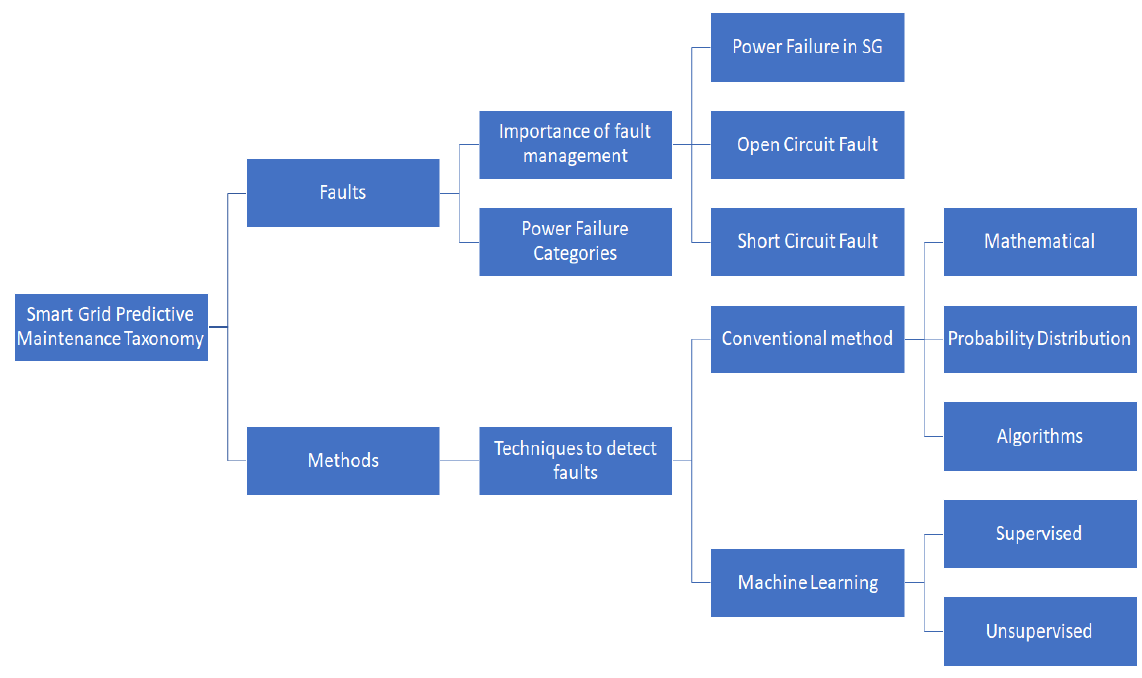
Figure 1. Smart grid predictive maintenance taxonomy.